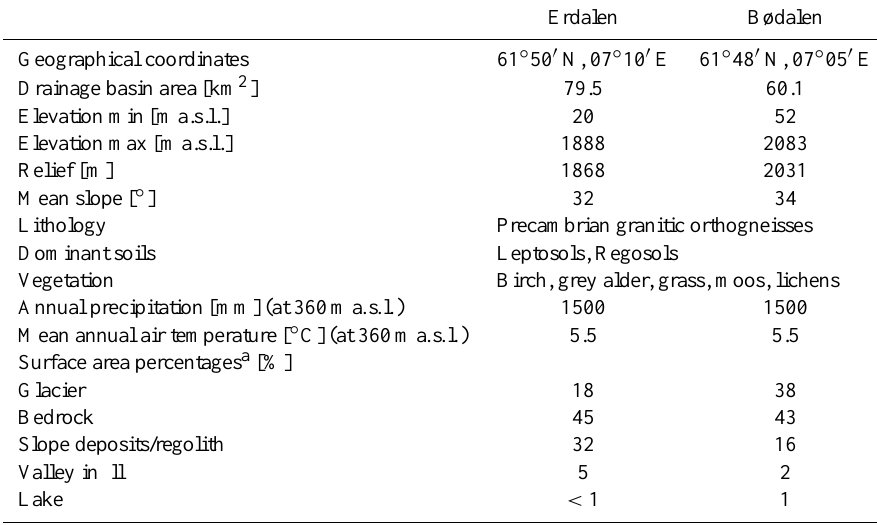
Table 1. Physiographic and climatic characteristics of the drainage basins of Erdalen and Bødalen (Nordfjord region, Norway). Erdalen Bødalen Geographical coordinates